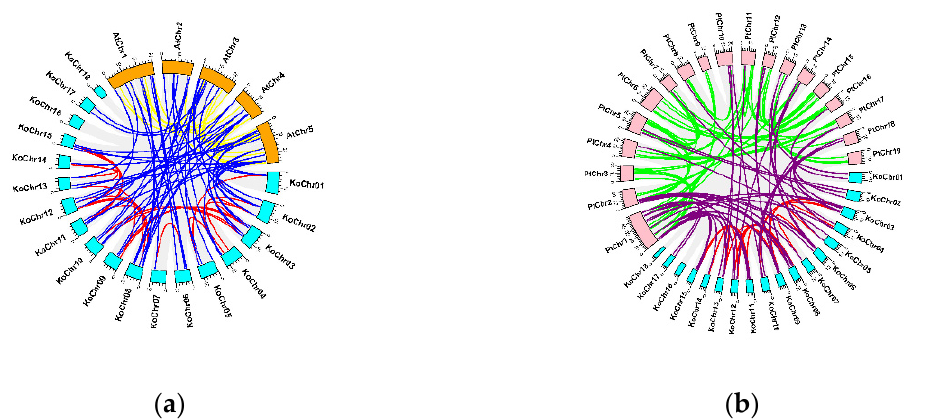
Figure 5. Collinearity analysis of Ko NAC genes. ( a ) Genes in 5 chromosomes of A. thaliana ( At Chrs), in orange, and 18 chromosomes of K. obovata ( Ko Chrs), in cyan, are introduced here. The orthologous pairs between Ko NACs and A NACs are highlighted in blue. The gene pairs among A NACs are colored in yellow, while the gene pairs among KoNAC s are colored in red. ( b ) Genes in 19 chromosomes of P. trichocarpa ( Pt Chrs), in pink, and 18 chromosomes of K. obovata ( Ko Chrs), in cyan, are introduced here. The orthologous pairs between Ko NACs and Pt NACs are highlighted in purple. The gene pairs among Pt NACs are colored in green, while the gene pairs among Ko NACs are colored in red.